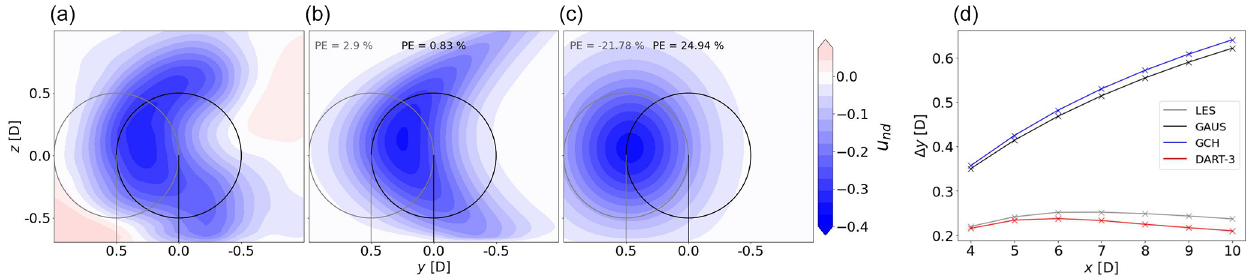
Figure 11. Case study of a turbine in a weakly stable boundary layer (BL3, φ =+ 30 ◦ , β = 0 ◦ ). Cross-section of normalized wake deficit (contours) of the LES (a) , DART-3 (b) and GAUS (c) at x = 6D downstream. (d) Wake center trajectory at 4D ≤ x ≤ 10D.